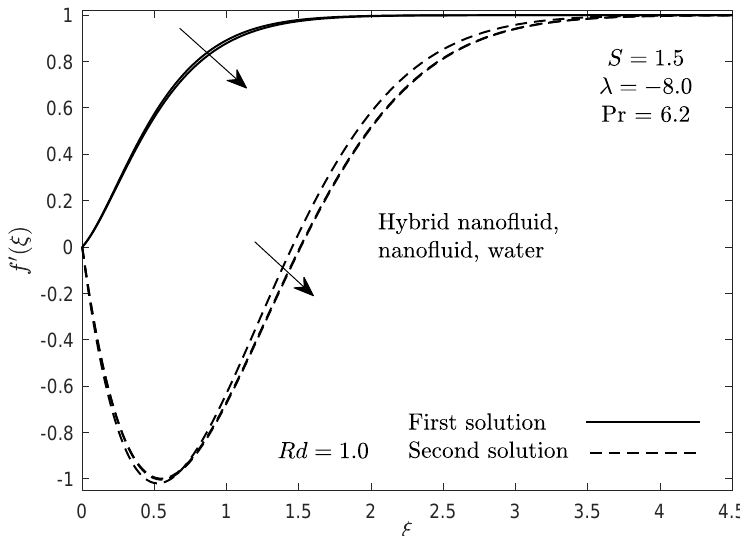
Figure 8. Impact of different fluids on velocity distributions, f (cid:48) ( ξ ) .